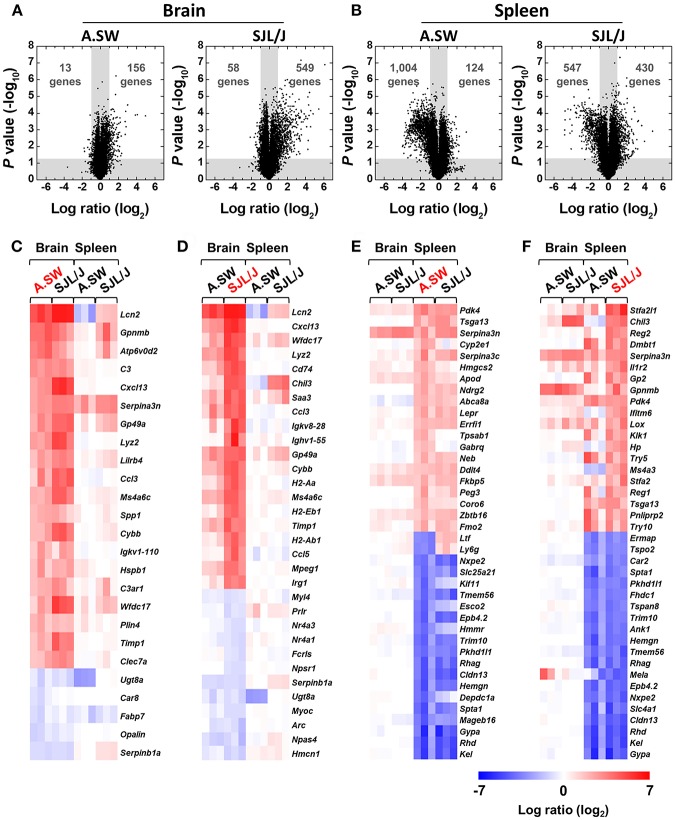
(A,B) Volcano plots of up- or down-regulated genes in the brains (A) and spleens (B) of PP-EAE mice. Gene expression profiles in the brains and spleens of three mice with PP-EAE at the disease peak and three age-matched control mice for each mouse strain were determined by microarray. Fold changes were calculated by division of signal values of EAE samples by those of controls. P values were calculated using the Student t test. Dots in the white areas were genes whose expressions were up- or down-regulated more than 2-fold (log2 ratio = 1, compared with controls), significantly (P < 0.05). In the brain, SJL/J mice had substantially higher numbers of both up- and down-regulated genes, compared with A.SW mice. On the other hand, in the spleen, SJL/J mice had a higher number of up-regulated genes, but a lower number of down-regulated genes, compared with A.SW mice. (C–F) Heat maps of identified genes among most highly up- or down-regulated 20 genes in the brains and spleens at disease peak of PP-EAE. Red, blue, and white indicate up-regulation, down-regulation, and no change, respectively. (C) In the brains of A.SW mice with PP-EAE, significantly up-regulated genes included: lipocalin 2 (Lcn2), complement-related genes, and chemokines. (D) In the brains of SJL/J mice with PP-EAE, Lcn2, chemokine-, MHC molecule-, and immunoglobulin-related genes were highly up-regulated. (E,F) In the spleens of both A.SW (E) and SJL/J (F) mice with PP-EAE, erythrocyte-related genes were down-regulated significantly. Overall, heat maps between A.SW and SJL/J mice were similar in the brains or spleens. A list of abbreviations of genes is shown in Supplemental Table 1.